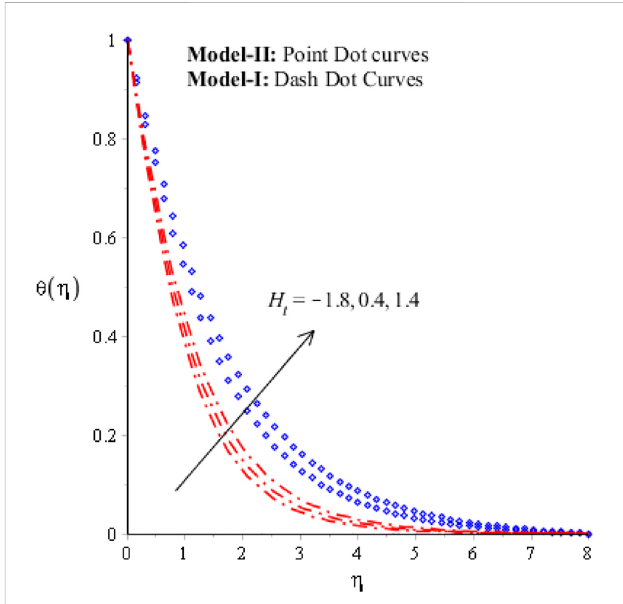
FIGURE 4 Effect of β on velocity curves when α (cid:2) 0 . 7 , n (cid:2) 0 . 3 , Re (cid:2) 3 . 0 , We (cid:2) 2 . 5 , γ (cid:2) 0 . 2 , Λ (cid:2) 0 . 32 , Pr (cid:2) 5 , ϵ (cid:2) 0 . 7 , H t (cid:2) − 1 . 5 , Sc (cid:2) 0 . 4 , λ (cid:2) 0 . 3 , K c (cid:2) − 1 . 7 , χ (cid:2) 0 . 0 , and τ (cid:2) 0 . 3.